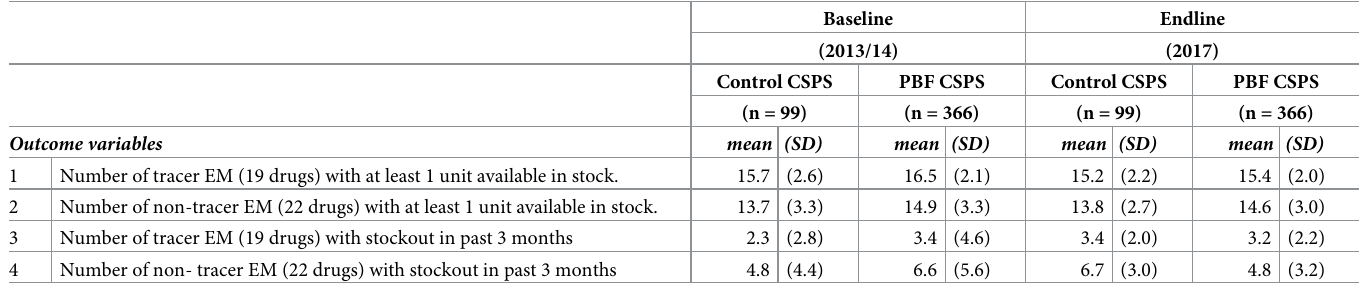
Table 3. Descriptive results for each outcome variable by study arm and time